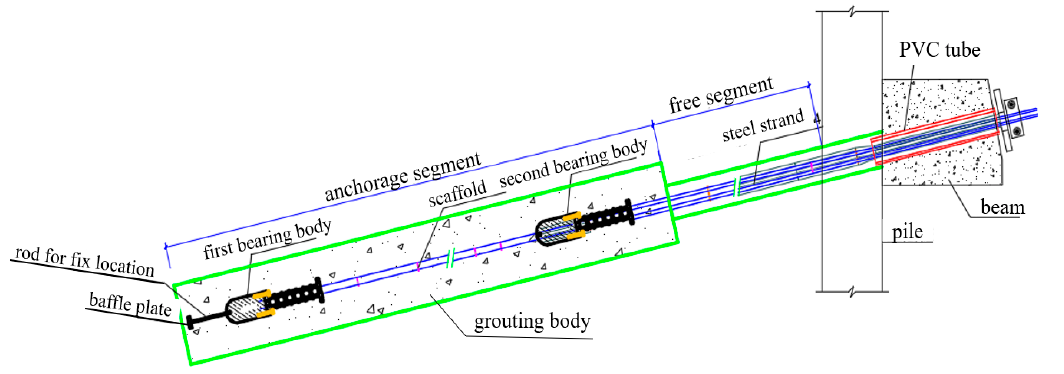
Figure 1. Schematic diagram of expanded anchor cable.